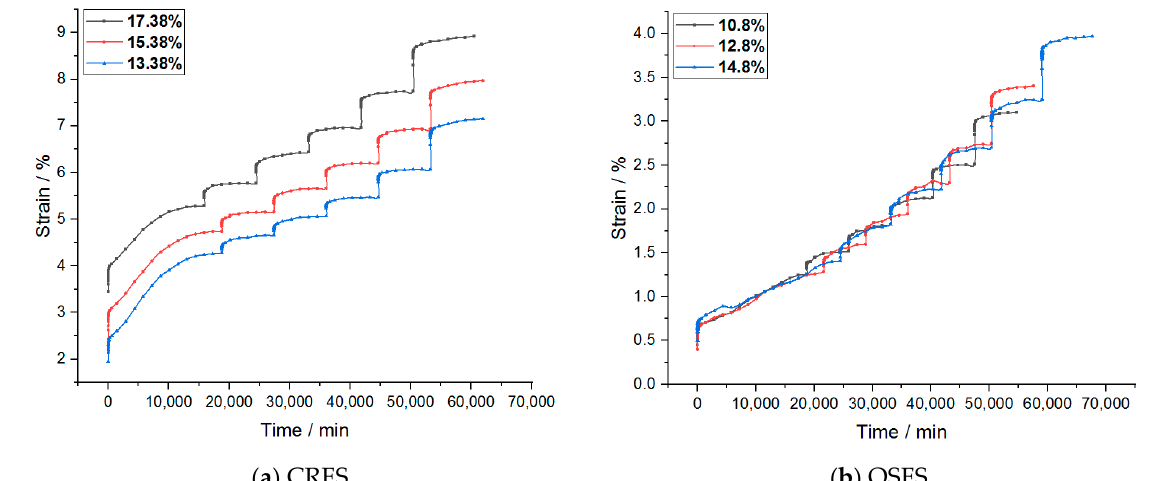
Figure 3. Strain–time curves of samples with different water contents.